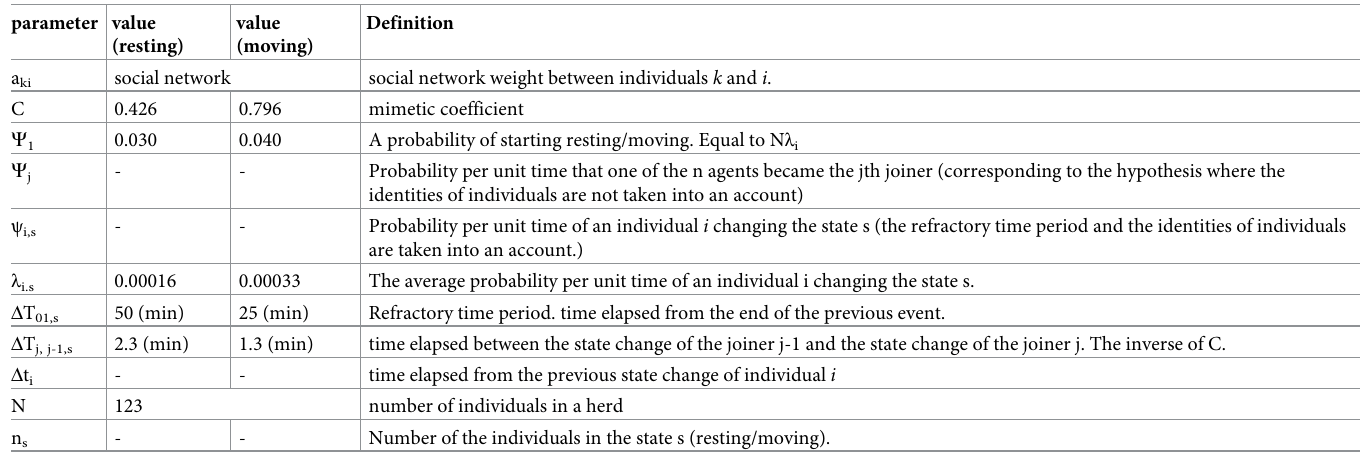
Table 1. The explanation and values of parameters.